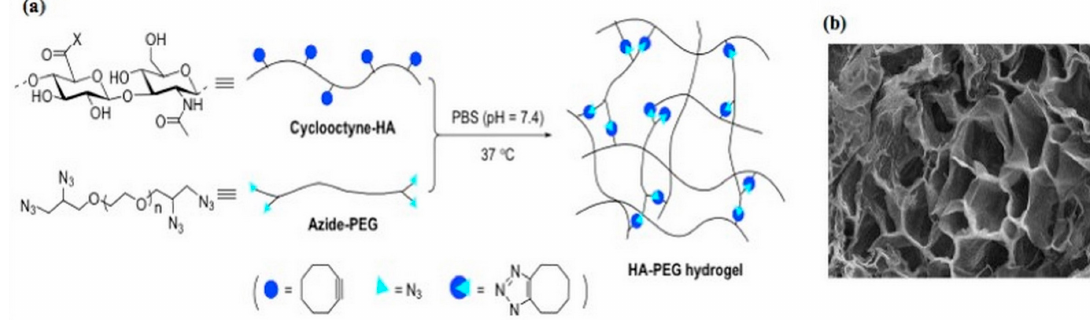
Figure 1. Preparation of the HA-PEG hydrogel ( a ), SEM image of the hydrogel ( b ) [31]. Reproduced with permission from Elsevier, 2017.